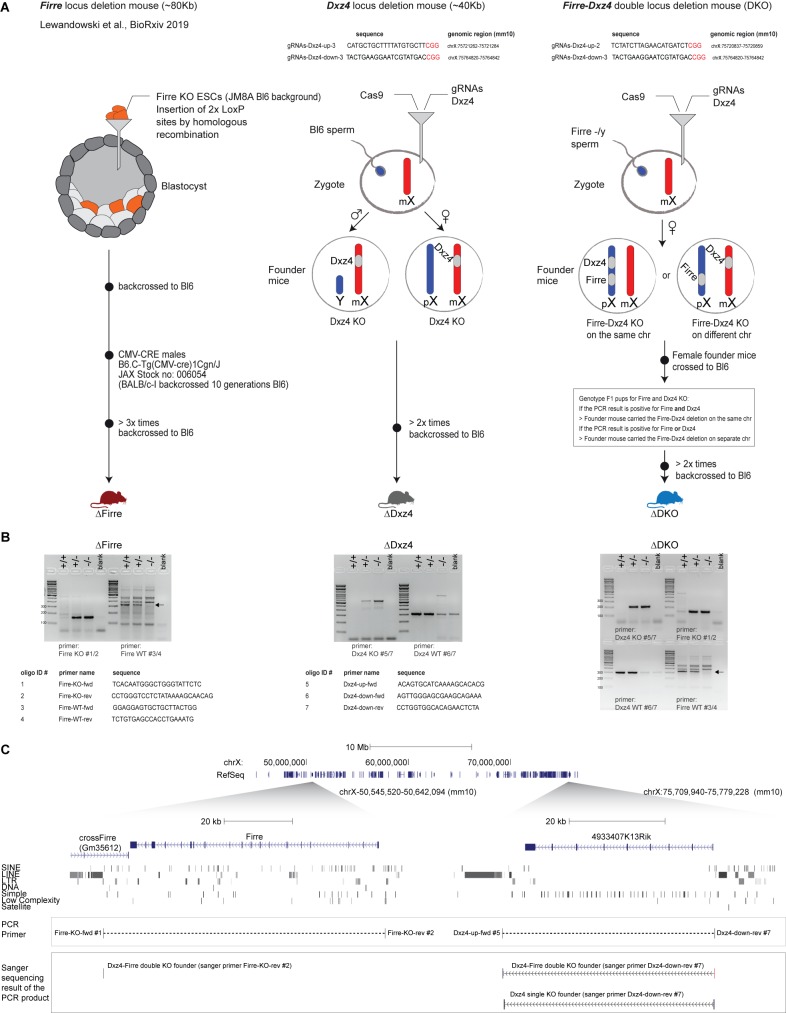
Generation of mice that carry a single or double deletion of Firre and Dxz4.(A) Schematic overview of the three genome-editing strategies, more details in the Materials and methods section. (B) Genotype strategy and required primers to identify the KO and WT allele for Firre and Dxz4 (C) UCSC genome browser showing the Firre and Dxz4 region. The PCR product of the KO bands was Sanger sequenced, and the resulting sequence was aligned to the UCSC genome browser to confirm the deletion of these loci.